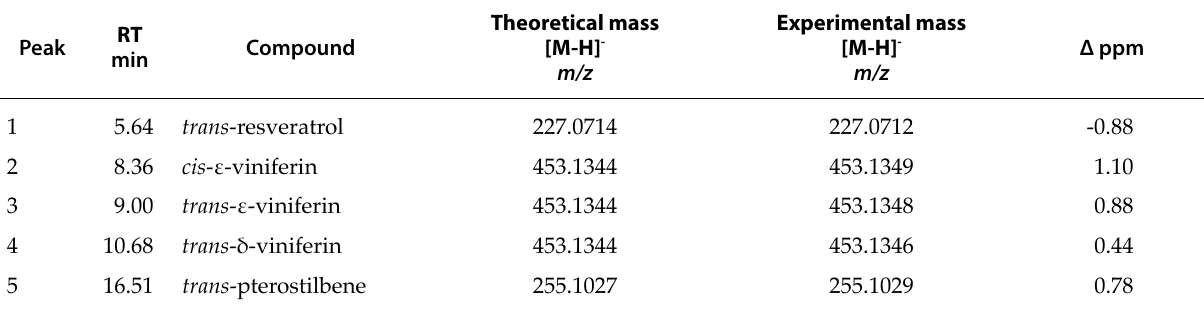
Table 2. Chromatographic retention times, and theoretical and experimental masses of pseudo-molecular ions of trans -res- veratrol and stilbene derivatives identified in a symptomatic grapevine leaf extract prepared using the procedure selected (E2; see